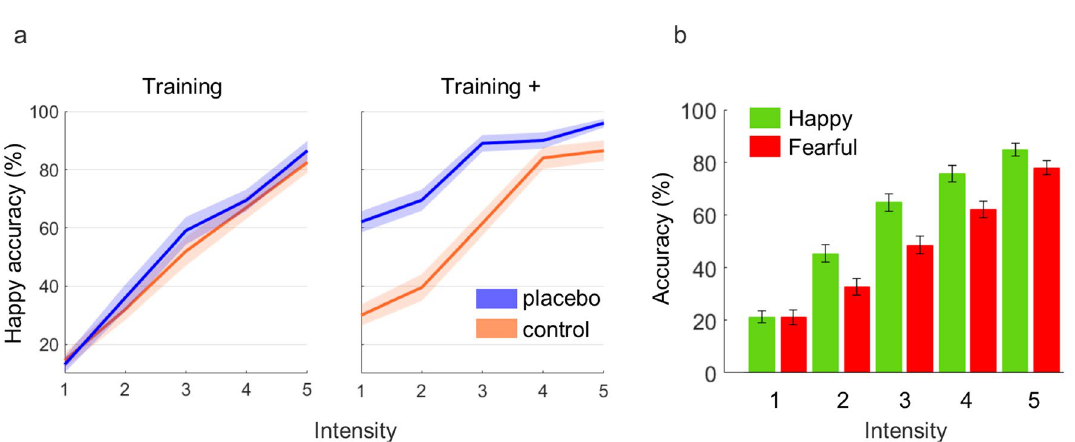
Figure 3. Classification accuracy. ( a ) Mean and s.e.m. of classification accuracy for happy expressions in training (left) and training + (right) sets for the placebo (blue) and control (orange) conditions. ( b ) Group means and s.e.m. of classification accuracy in the main task for happy (green) and fearful (red) expressions during the control condition at five steps of expression